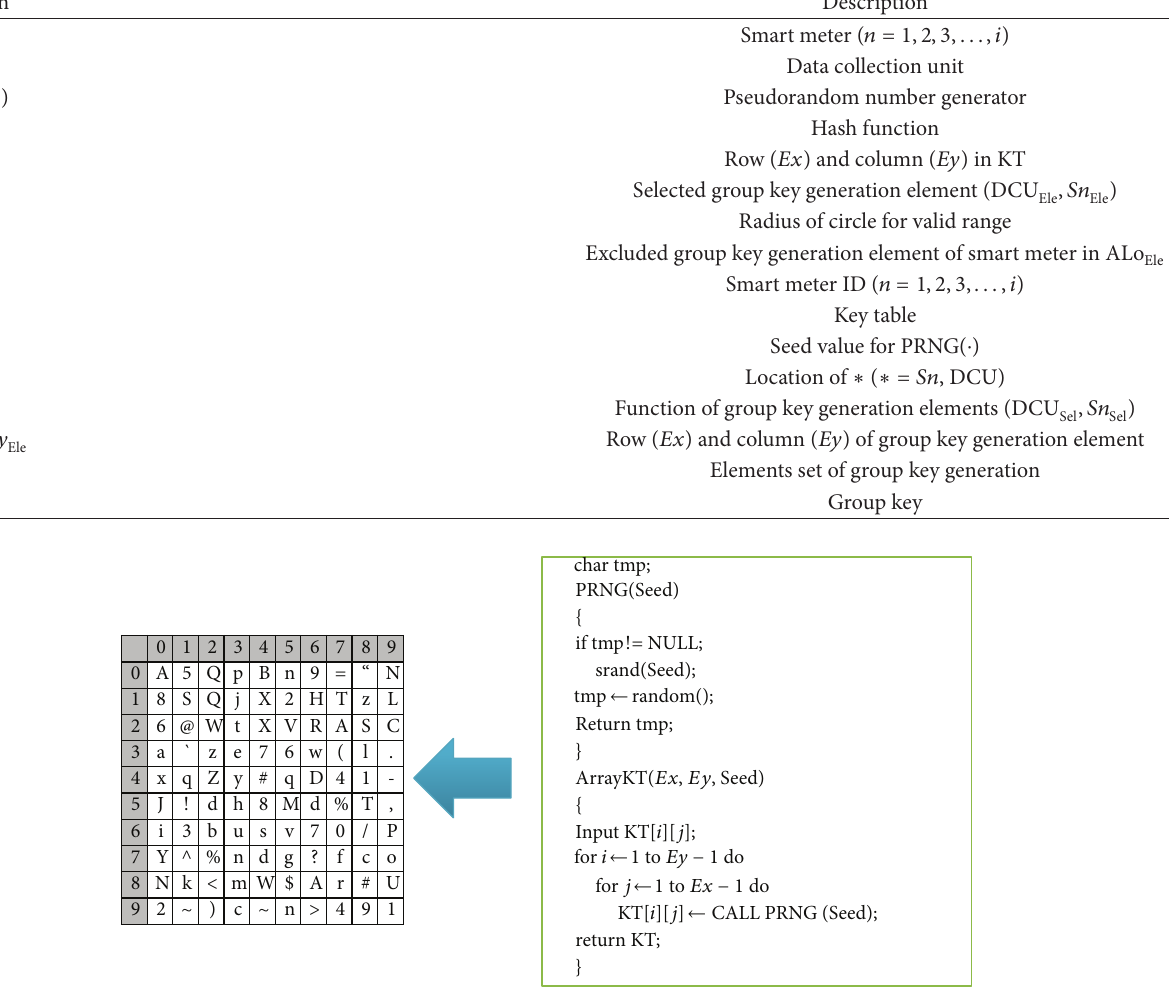
Table 3: Notations used in proposed scheme.